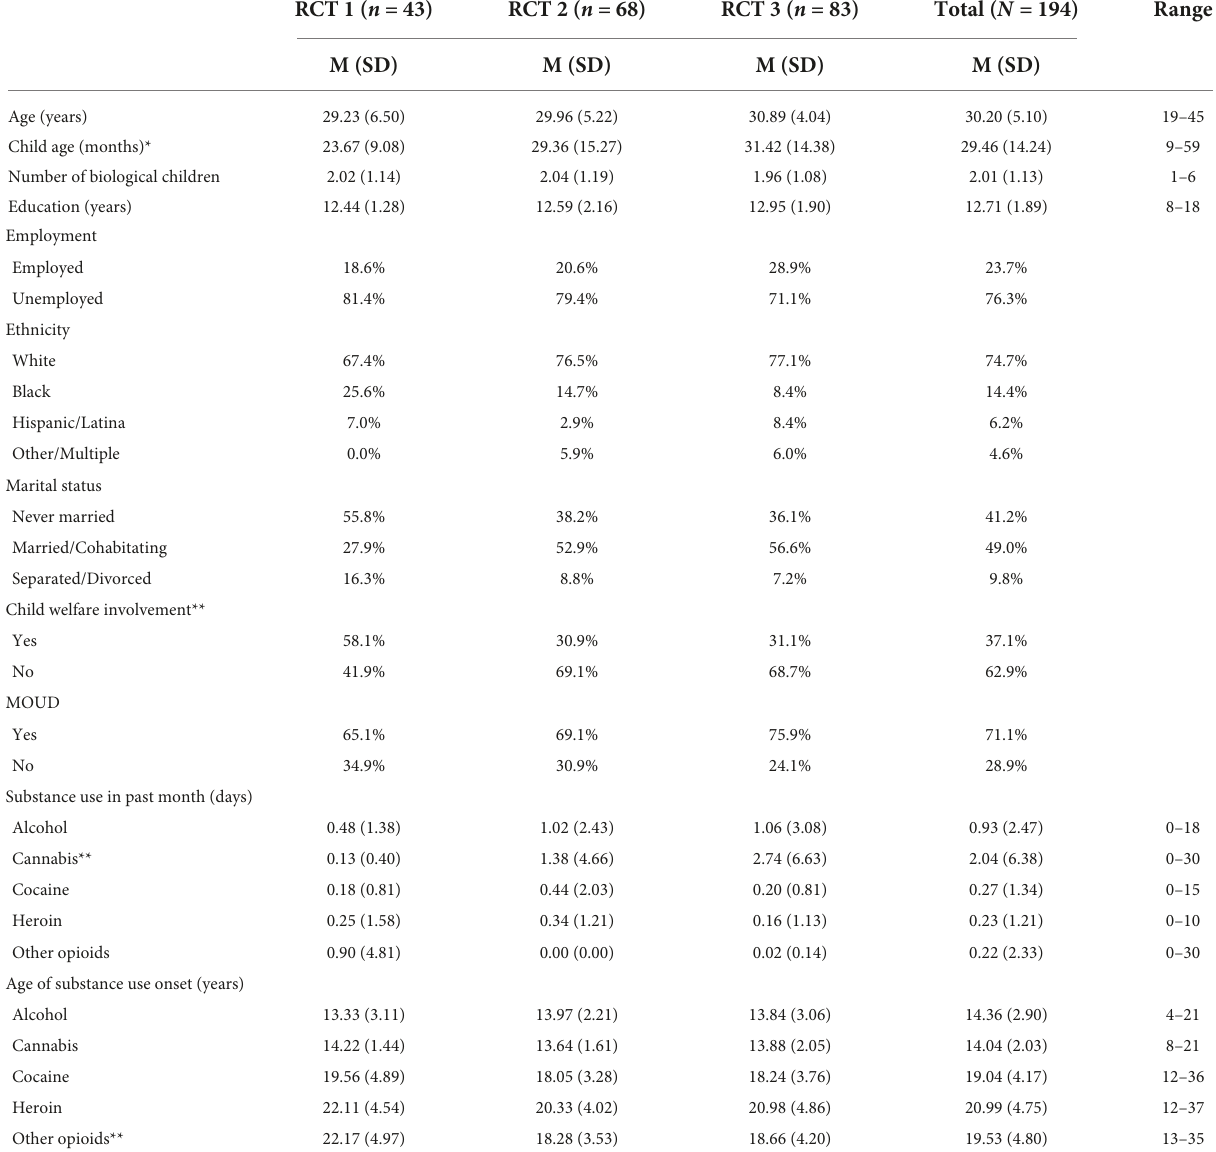
TABLE 1 Demographic characteristics by